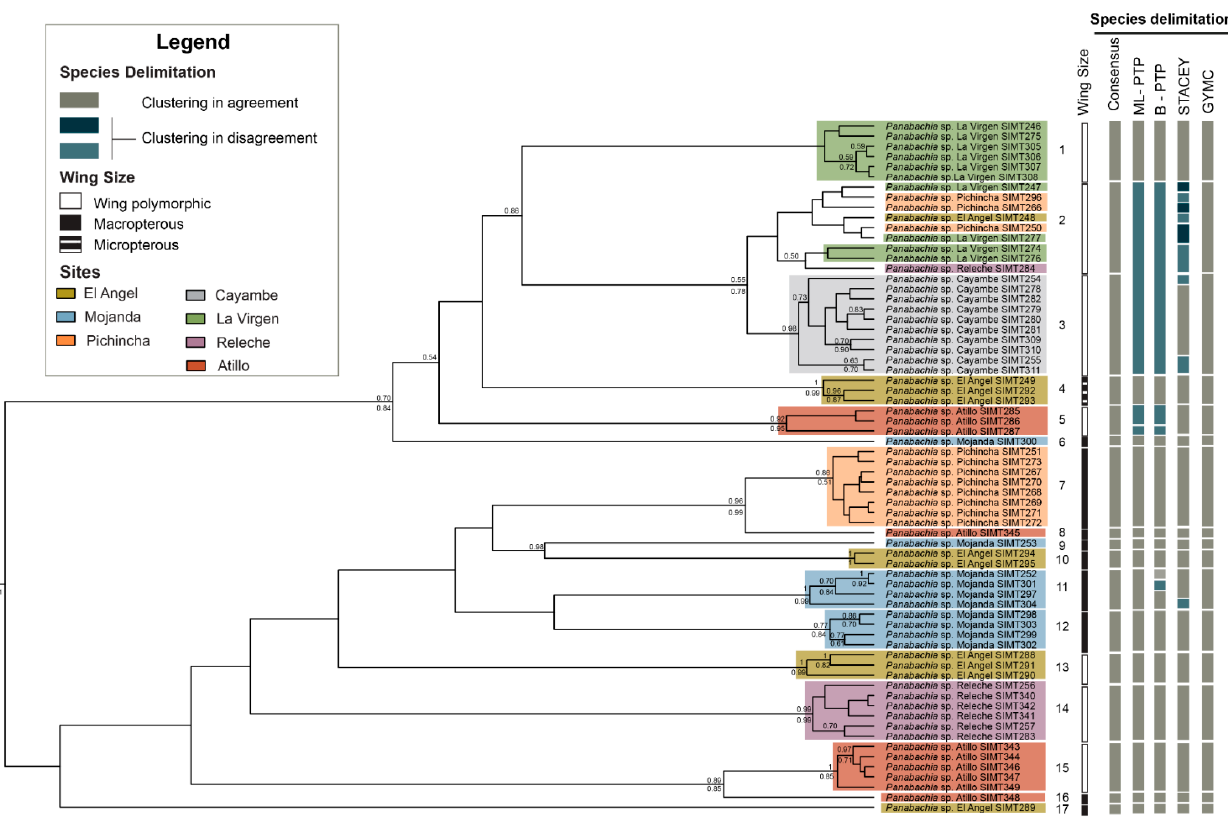
Figure 4. Bayesian inference based on a combined data set for Panabachia putative species. Colored bars represent site information, and species delimitation analysis using bPTP, STACEY and GMYC are represented by bars on the right side of the phylogeny. The grey color on the bars signifies there is an agreement across methods of delimitation, while the color blue signifies that there is disagreement across methods, and the two shades of blue signify that they belong to the same group within each clade. Wing size is represented in bars, white colored bars indicate wing polymorphic clades (micropterous and macropterous), black bars macropterous clades, and the black and white bar represents a micropterous clade. Posterior probabilities are shown above the branches and RAxML bootstrap values are shown below branches. Branch lengths are not proportional with the number of changes.